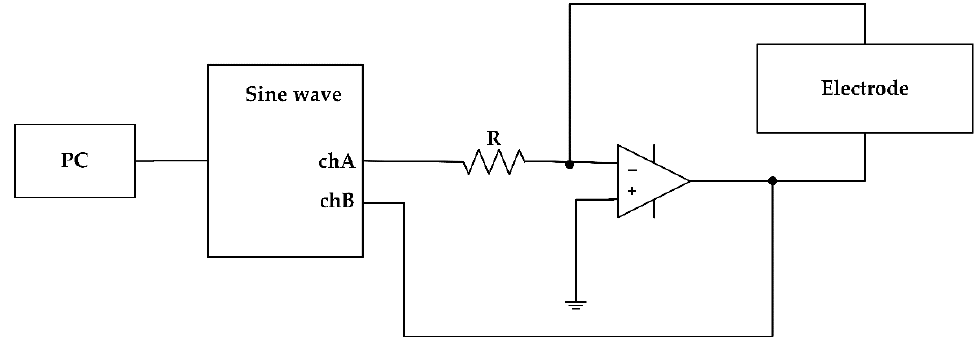
Figure 1. Impedance-based measurement system.